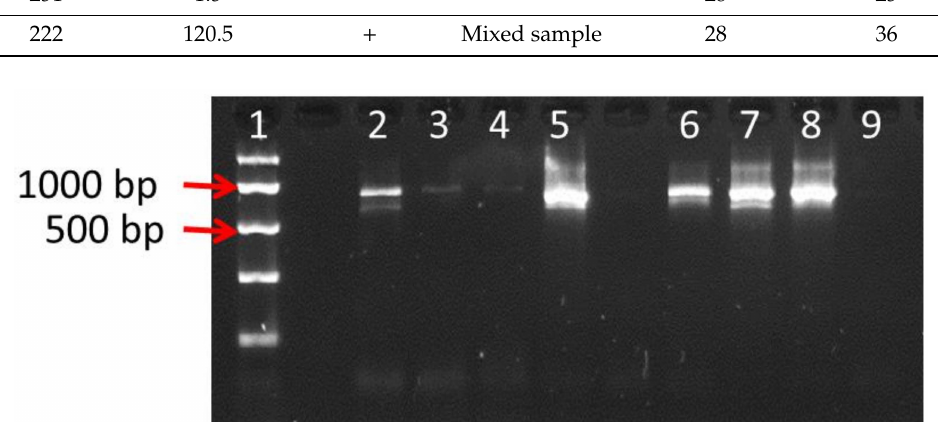
Figure 1. Agarose gel electrophoresis of PCRs using internal transcribed spacer 1 (ITS1) and ITS4 primers. Gel lanes: 1-Easy Ladder I (Bioline); 2-Positive control; 3-Sample 215; 4-Sample 215; 5-Sample 218; 6-Sample 224; 7-Sample 228; 8-Sample 229; 9-Negative (no template)